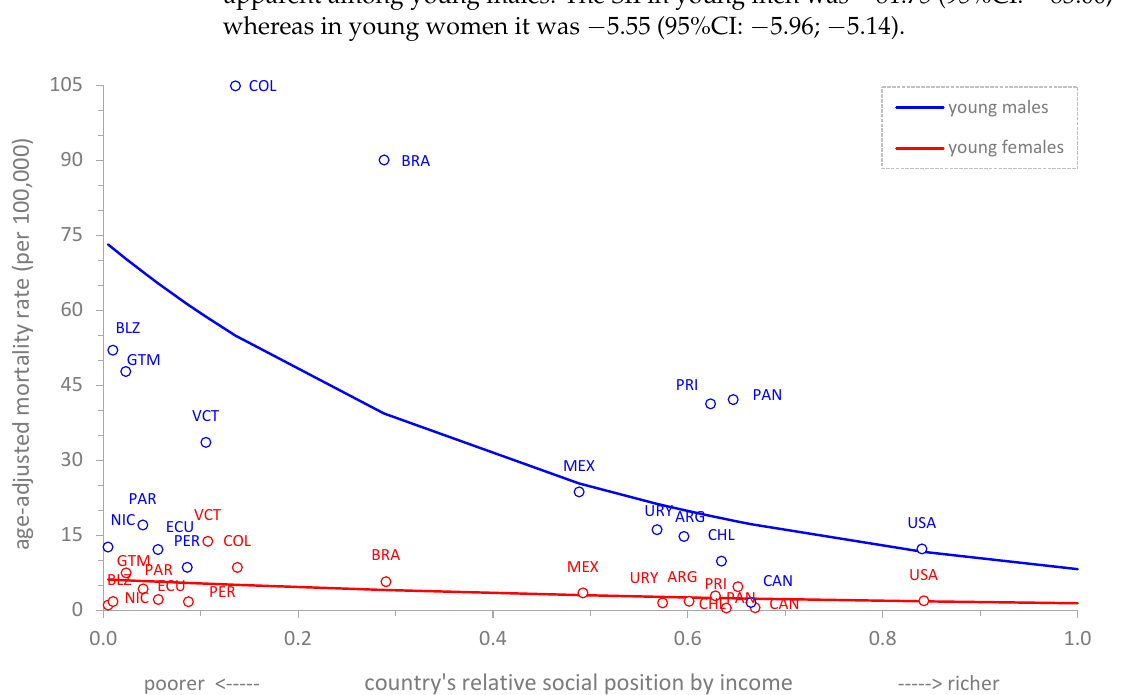
Figure 2. Cross-country income-related inequality gradients in mortality due to homicide in young (10–24 years old) males and females. Region of the Americas, 2015.